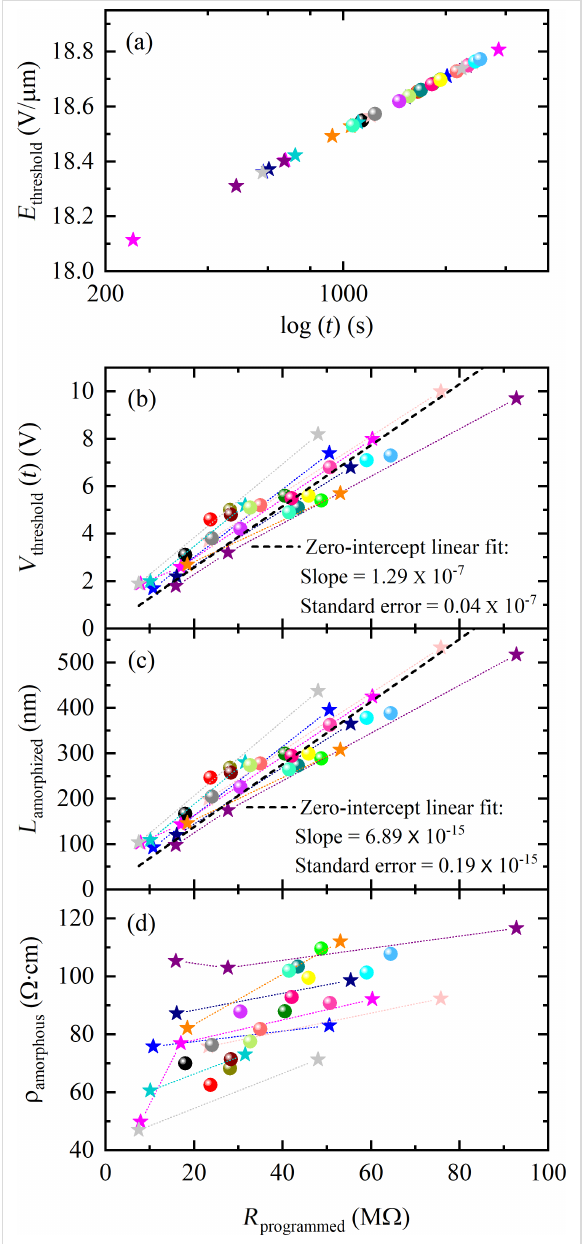
Figure 7: (a) Logarithmic upward drift of the threshold field E threshold ( t ) for 25 identical cells [20,29] as a function of the elapsed time after amorphization t . (b) Measured threshold voltage V threshold ( t ) as a func- tion of the measured R programmed . (c) Calculated L amorphized values as a function of the measured R programmed values, and (d) calculated ρ amorphous (10 s) values as a function of the measured R programmed values. The data points for different cells are plotted with different colors. Cells that demonstrated multiple re-amorphization events are plotted with stars connected with dotted lines (8 out of 25 cells) and the ones experiencing a single re-amorphization event are plotted with spheres (17 out of 25 cells).